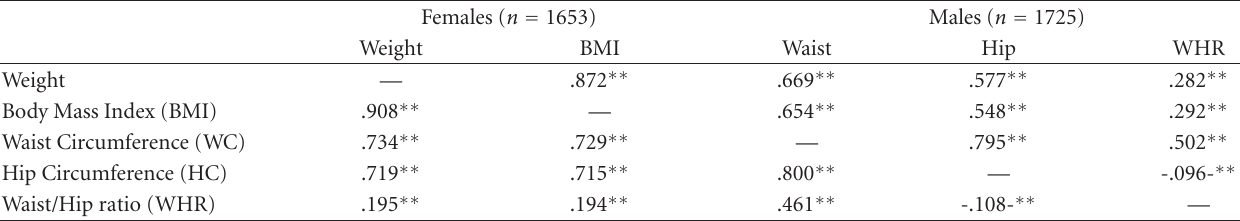
Table 2: Age-adjusted partial correlation coe ffi cient among anthropometric measures in Palestinian adults: findings of the first national health and nutrition survey (FNHANS) 1999-2000.